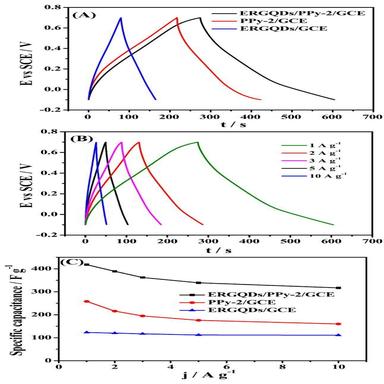
(A) GCD curves of ERGQDs/GCE, PPy-2/GCE and ERGQDs/PPy-2/GCE at the current density of 1 A g − 1. (B) GCD curves of ERGQDs/PPy-2/GCE at the current density of 1, 2, 3, 5 and 10 A g − 1. (C) Specific capacitances of ERGQDs, PPy-2 and ERGQDs/PPy-2 at various current densities.